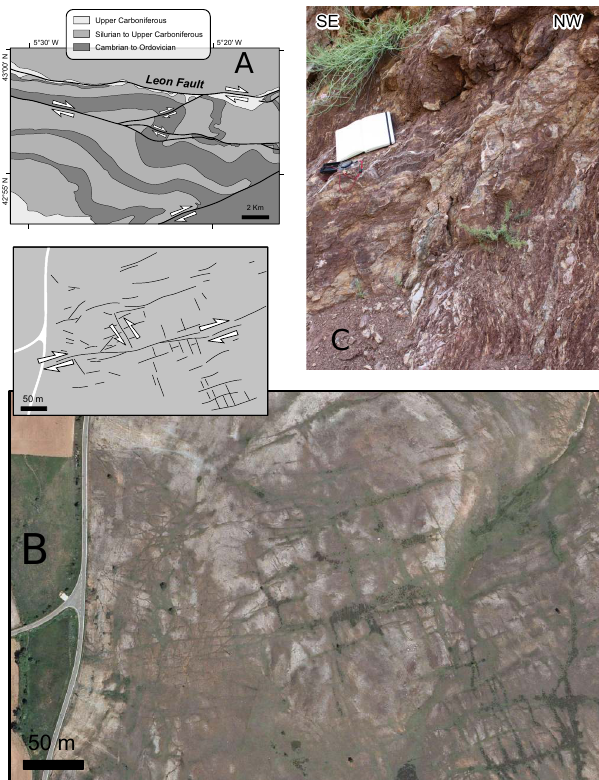
Fig. 18. (A) Schematic geological map in the area to the south of the Leon Fault. (B) Orthophoto and line-drawing of an area of the Duero Basin (see Fig. 18 for location) where subhorizontal Ceno- zoic layers are exposed. NNW-SSE and WSW-ENE striking frac- ture traces may correspond to early-orogenic extensional assem- blages, which have been documented to the east by Quint`a and Ta- vani (2012). These are postdated by an about E-W striking fault, whose right-lateral kinematics is well-constrained by its antithetic left-lateral fault. (C) Right-lateral calcite slickenlines along a – the Leon Fault